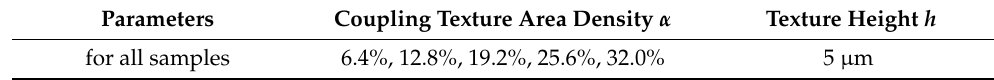
Figure 2. Schematic diagram of the crescentiform surface: ( a ) the crescentiform surface prepared by Cui et al., ( b ) the crescentiform surface prepared by Tang et al., ( c ) the three-dimensional schematic diagram of the crescentiform surface in this experiment, and ( d ) the crescentiform surface dimensions. Table 1. Parameters for the array of textured pattern.